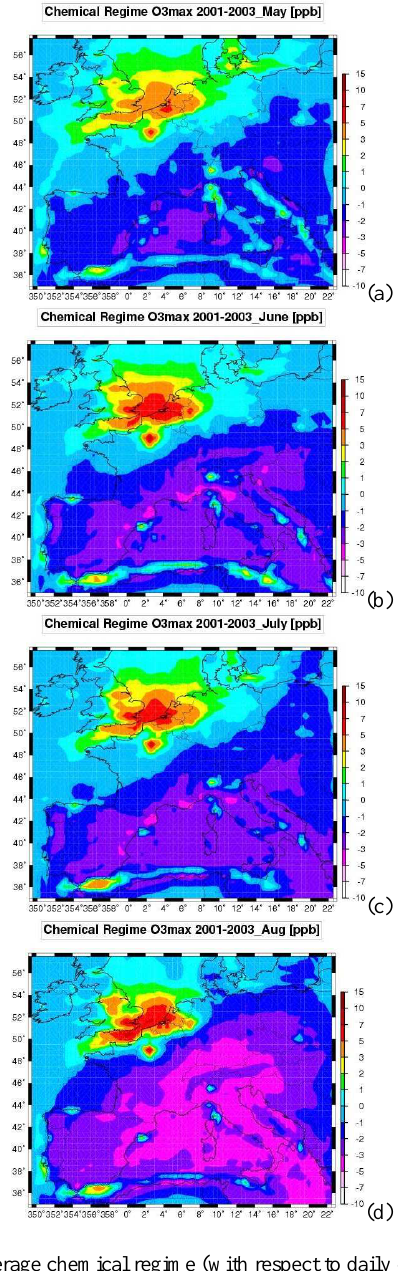
Fig. 5. Average chemical regime (with respect to daily ozone max- imum) (a) for May, (b) for June, (c) for July, (d) and for Au- gust